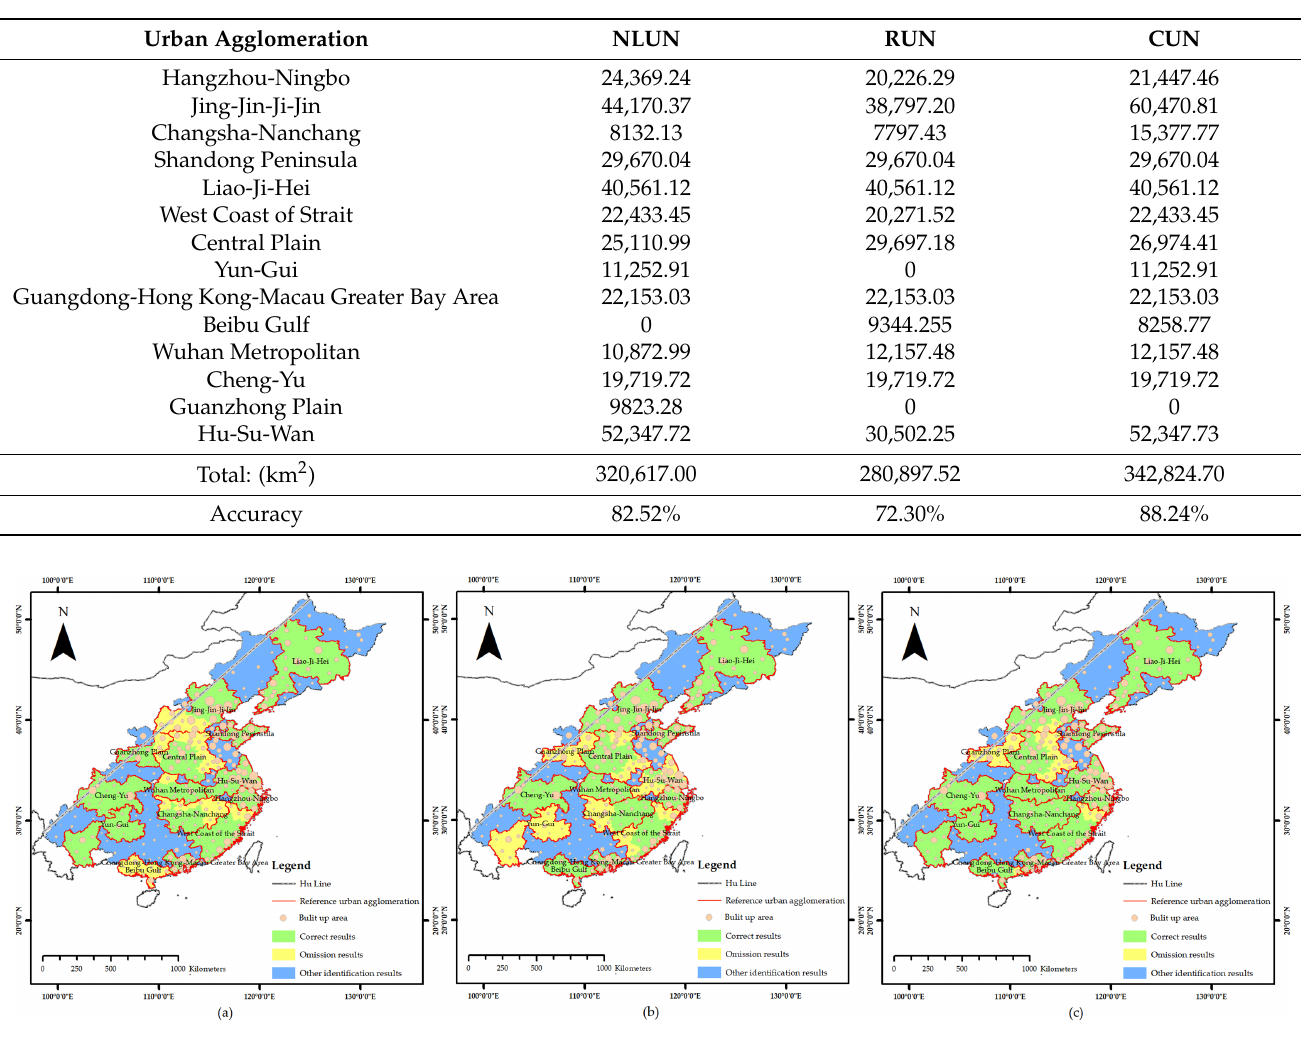
Table 3. Accuracy of urban agglomeration identification.